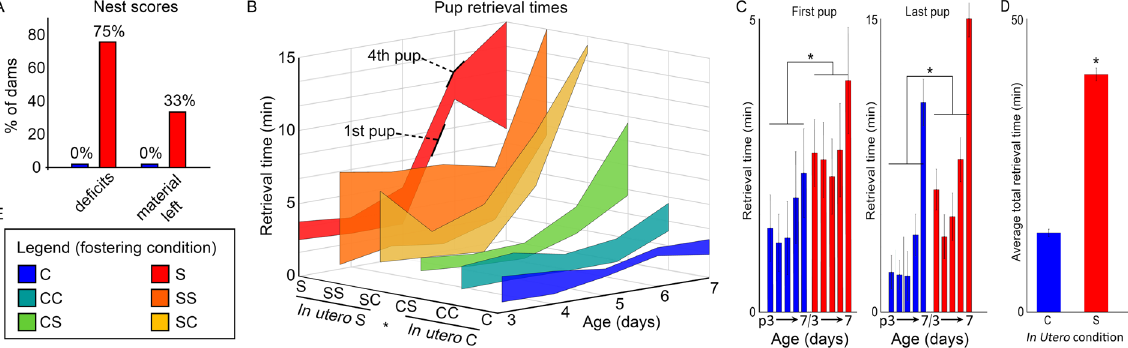
Figure 3. Maternal Behavior is altered by prenatal and postnatal DCCD. Before giving birth, 75% of S dams create nests with major structural deficits, and 33% do not use all nest material provided over the night of testing. By contrast, 0% of C dams exhibit these deficits in nest building ( A ). The condition of the pup in utero affects maternal pup retrieval behavior ( B – D ). A 3-dimenstional plot showing the time interval from retrieval of 1st to 4th pup (labeled as such on S data), which defines a region shaded by condition (B, legend in E) across 5 sequential days of retrieval trials. Pups experiencing in utero disruption (S, SS, SC) show longer retrieval times than pups from in utero control conditions (C, CC, CS), regardless of rearing-dam’s condition. As a group, dams retrieving pups that experienced in utero disruption take longer to retrieve the first (C, left) and last (C, right) pup, and this effect is present across all five trial days. A significant effect is also found in total amount of time spent retrieving pups across all 5 days ( D ), with in utero -disrupted pups taking longer to be retrieved than pups without in utero disruption.